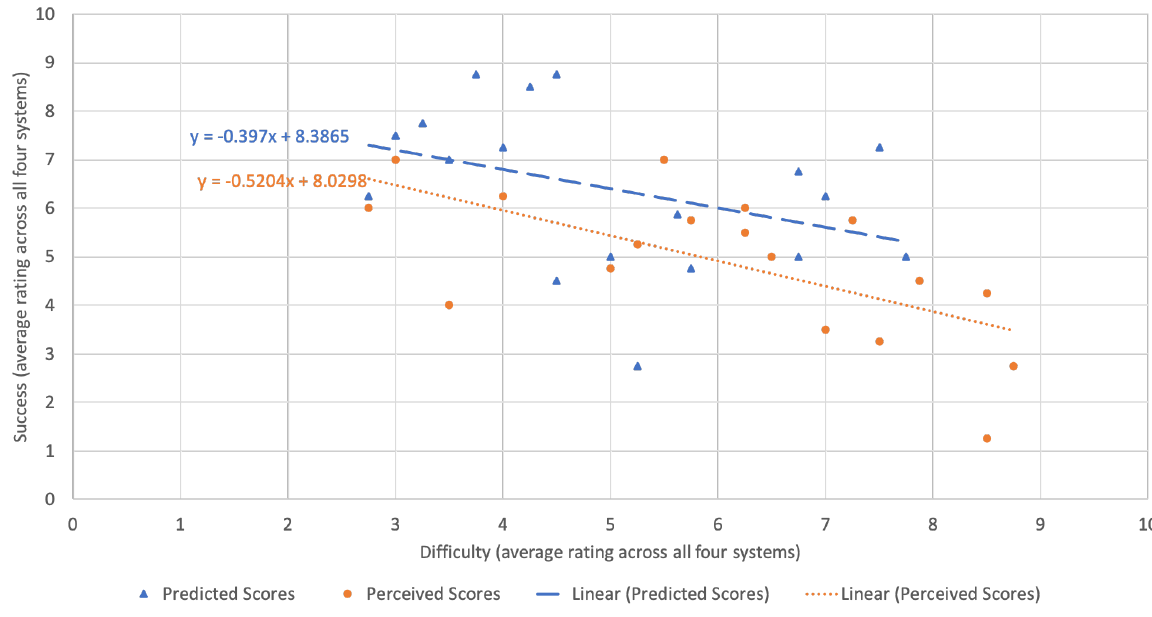
Figure 10: Each participant’s average Predicted (before the experience) scores for Diflculty and Success plotted as one point (a blue trian- gle), as well as each participant’s average Perceived (after the experience) scores for Diflculty and Success plotted as one point (an orange dot). The linear regression line for Predicted scores and linear regression line for Perceived scores applied. Both Predicted (with a slope of -0.397) and Perceived (with a slope of -0.5204) scores show a similarly negative relationship between Diflculty and